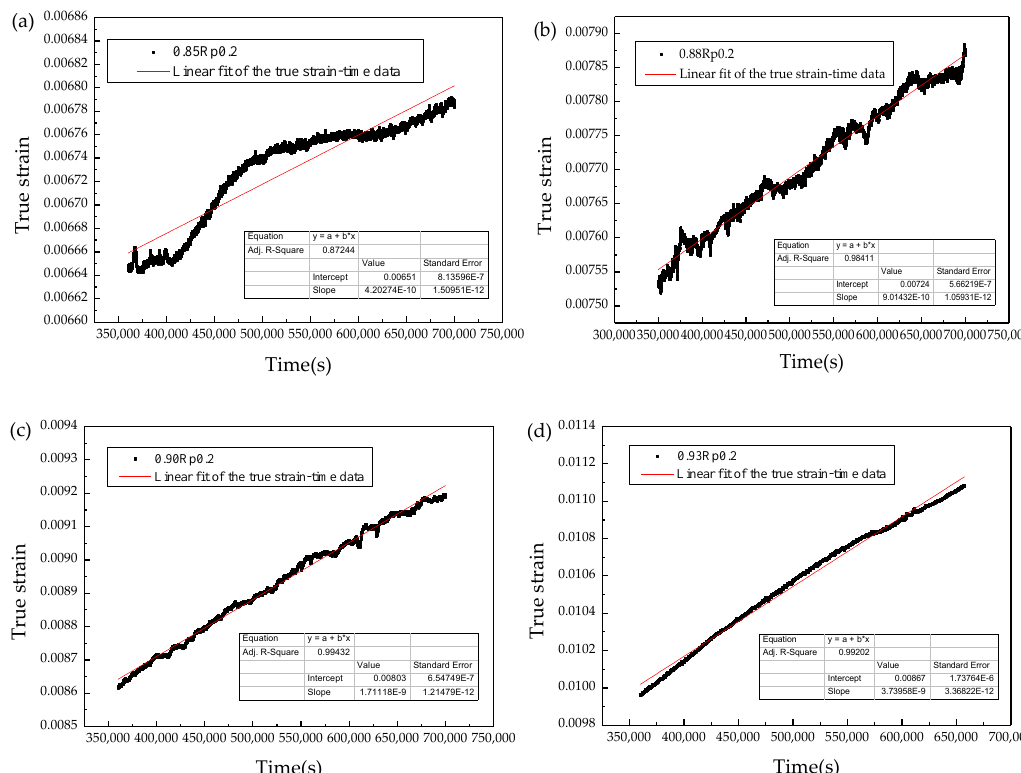
Figure 5. Linear fit of the true strain – time curve of TA31 alloy in the steady creep stage under compressive stresses of ( a ) 0.85Rp0.2; ( b ) 0.88Rp0.2; ( c ) 0.90Rp0.2; ( d ) 0.93Rp0.2.